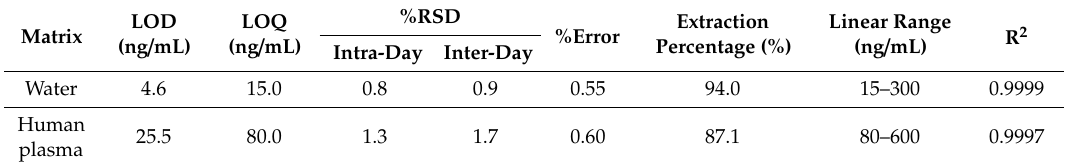
Table 2. Analytical performance data of the proposed method for extraction and determination of GEF from water and plasma samples.